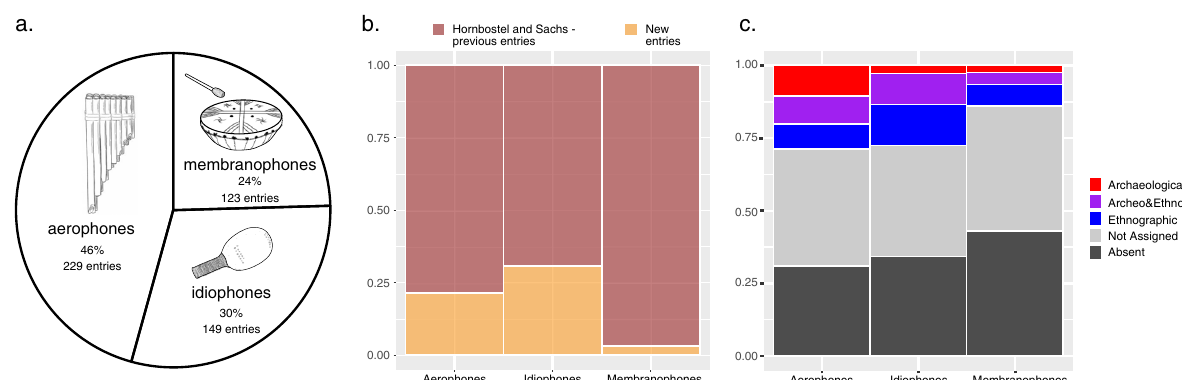
Fig. 3 Distribution of instruments according to the von Hornbostel and Sachs (1914) classi fi cation. a Number of entries for each instrument class in the global classi fi cation. b relative contribution of instruments (from Perez de Arce and Gili, 2013) compared to the von Hornbostel – Sachs (1914) classi fi cation and its revisions (MIMO consortium 2011; CIMCIM, 2017). c proportion of South American instruments per class, subdivided between historical/ancient presence (archaeological) and more recent use documented from